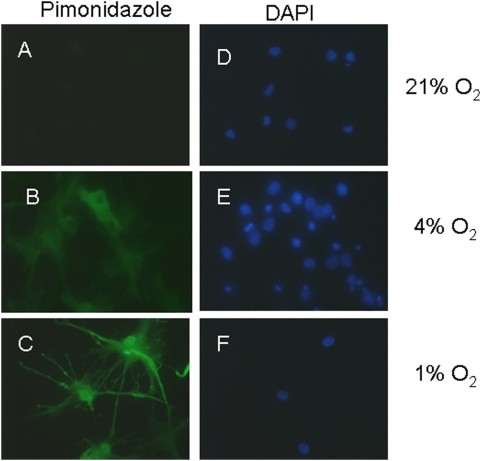
Demonstration of intracellular hypoxia.Intracellular hypoxia was assessed by incubating cells with pimonidazole (A, C and E), which forms adducts at pO2 of <10 mm Hg (green). Cells are counterstained with DAPI (B, D, and F; blue). Note absent staining in 21% O2 (A), moderate staining in 4% O2 (C), and high level staining in 1% O2 (E). Scale bars = 10 um. Data shown are representative of four separate studies.